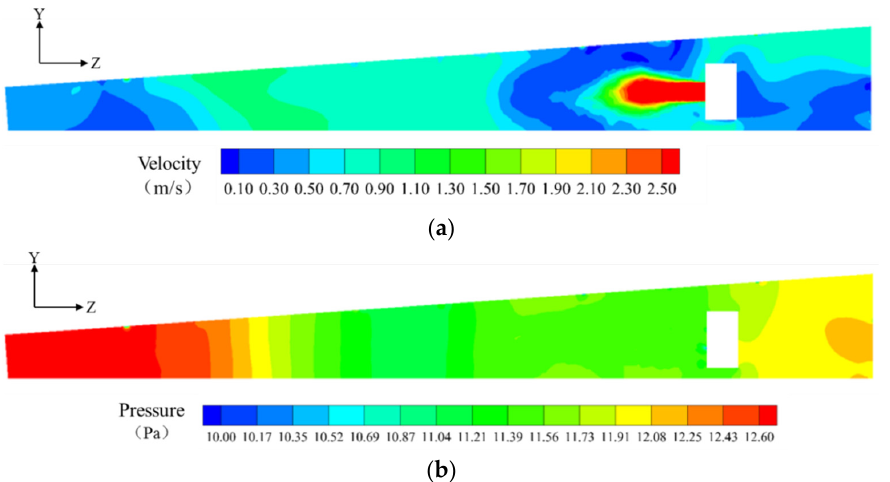
Figure 8. Velocity and pressure contours of the vortex area at y = 0.71 m under case A. ( a ) velocity contours and ( b ) pressure contours.